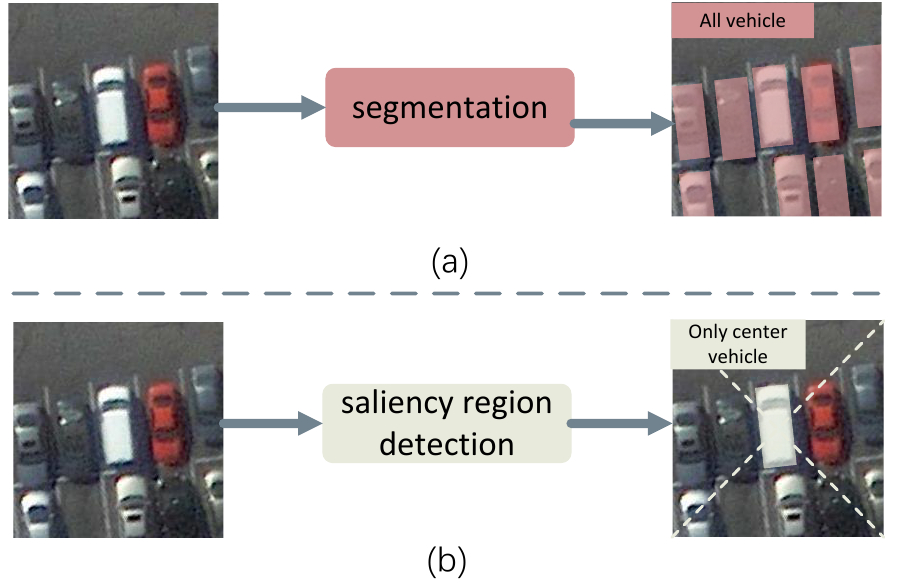
Figure 2. Difference between our saliency area ( b ) and binary segmentation ( a ). In our proposed SR-Net, we define only the vehicles at the center as the saliency area, i.e., the foreground. The saliency region is properly defined as the core of our SR-Net. Based on this definition, our results will not have the problem of sticking adjacent vehicle pixels. In contrast, the binary segmentation defines all vehicles as